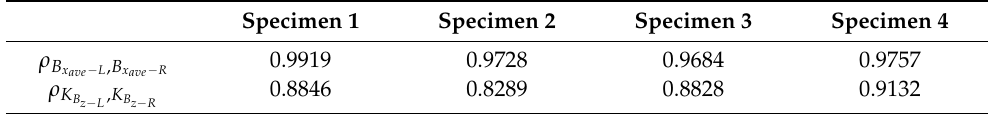
Table 4. Cross-correlation coefficients of the characteristics of all the